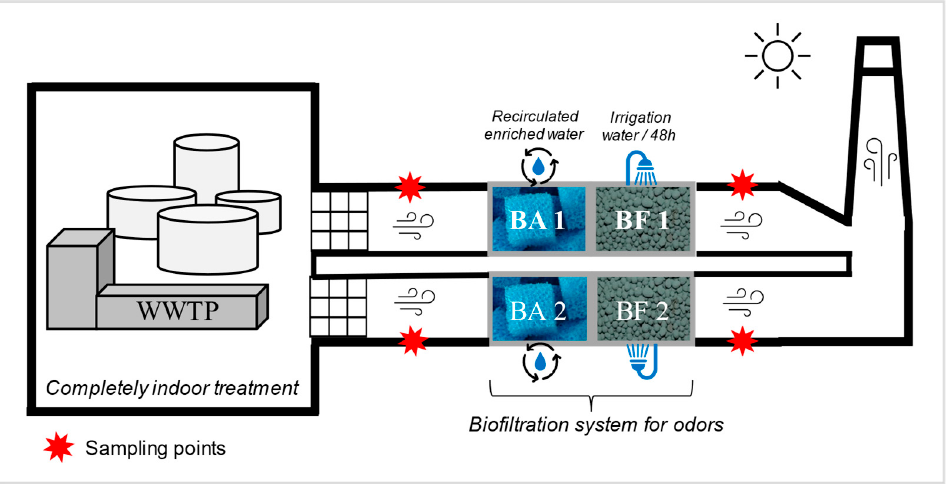
Figure 1. Schematic of the biofiltration system installation. Sampling points are indicated with red stars. The two channels are represented by 1 and 2. BA: bio ‐ atomizer; BF: biofilter.